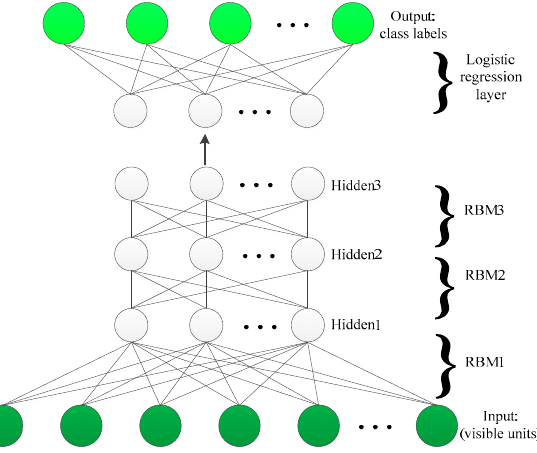
Figure 2. An illustration of three-layer DBN with logistic regression.